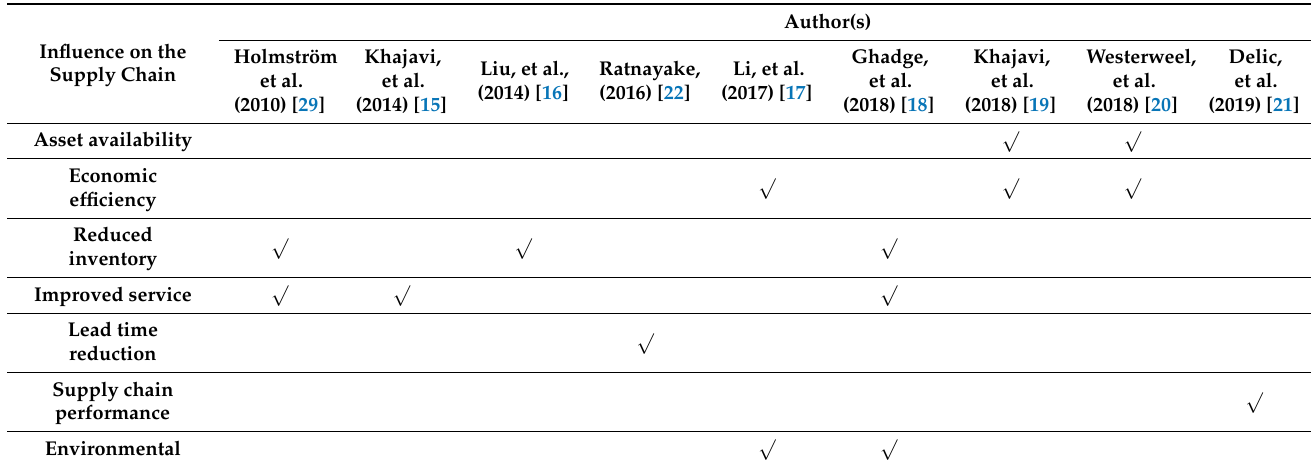
Table 1. Main positive effects of additive manufacturing on the spare part supply